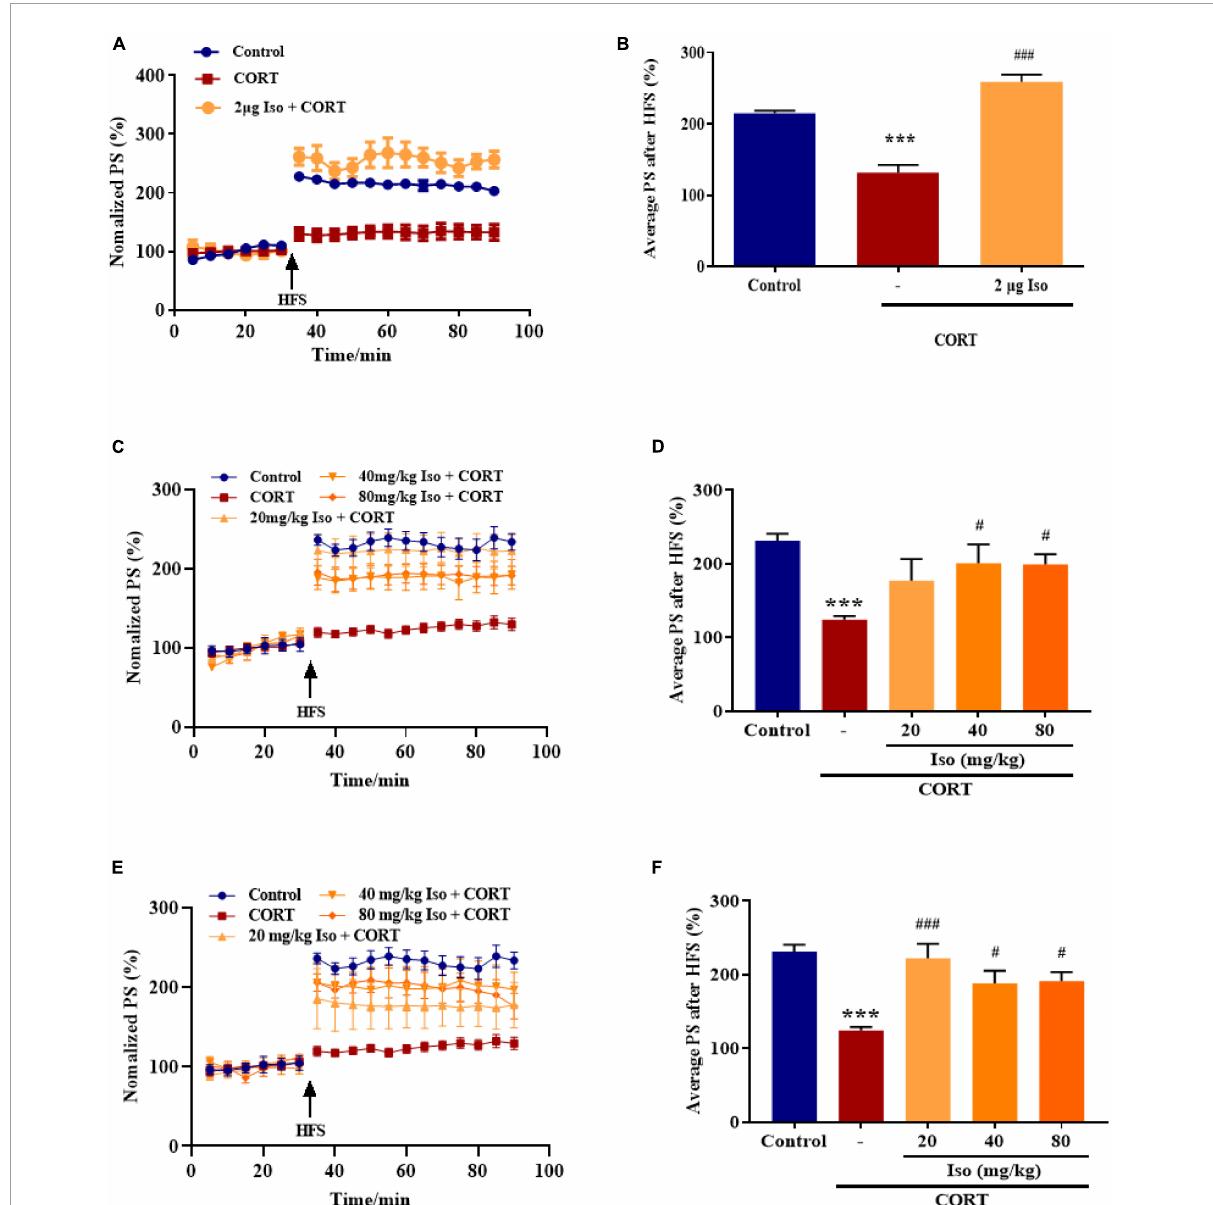
FIGURE1 Effects of isorhynchophylline on hippocampal LTP in corticosterone (CORT)-treated mice. (A) The time course of average relative PS amplitudes. (B) The average relative PS amplitudes post-HFS (31–90 min). Isorhynchophylline (2 µ g, i.c.v) significantly improved CORT-induced LTP impairment. CORT/vehicle was injected 60 min before HFS and isorhynchophylline was administrated 30 min before CORT/vehicle. (C) The time course of average relative PS amplitudes. (D) The average relative PS amplitudes post-HFS (31–90 min). Isorhynchophylline (40/80 mg/kg, i.g.) significantly improved CORT-induced LTP impairment. (E) The time course of average relative PS amplitudes. (F) The average relative PS amplitudes post-HFS (31–90 min). Isorhynchophylline (20/40/80 mg/kg for seven days, i.g.) significantly improved CORT-induced